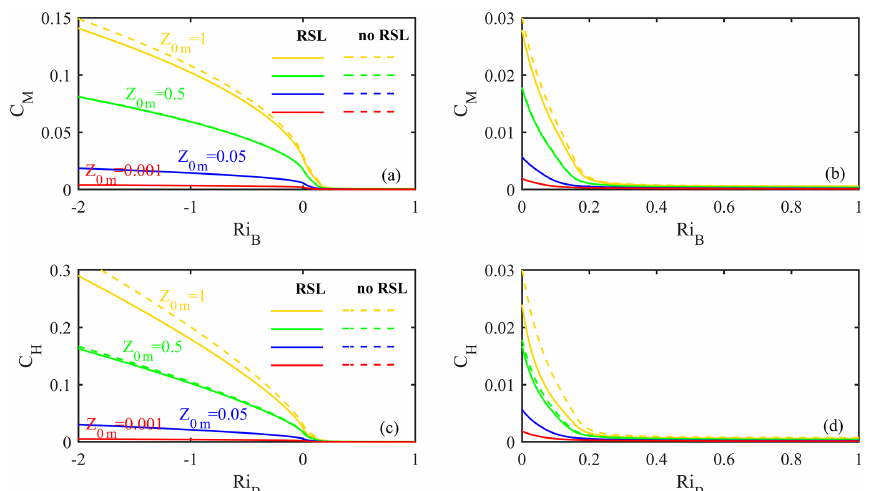
Figure 4. The relationships between C M (C H ) and Ri B under different z 0 m values and treatments of the RSL. Solid lines: considering the RSL effect; dotted lines: without the RSL effect.